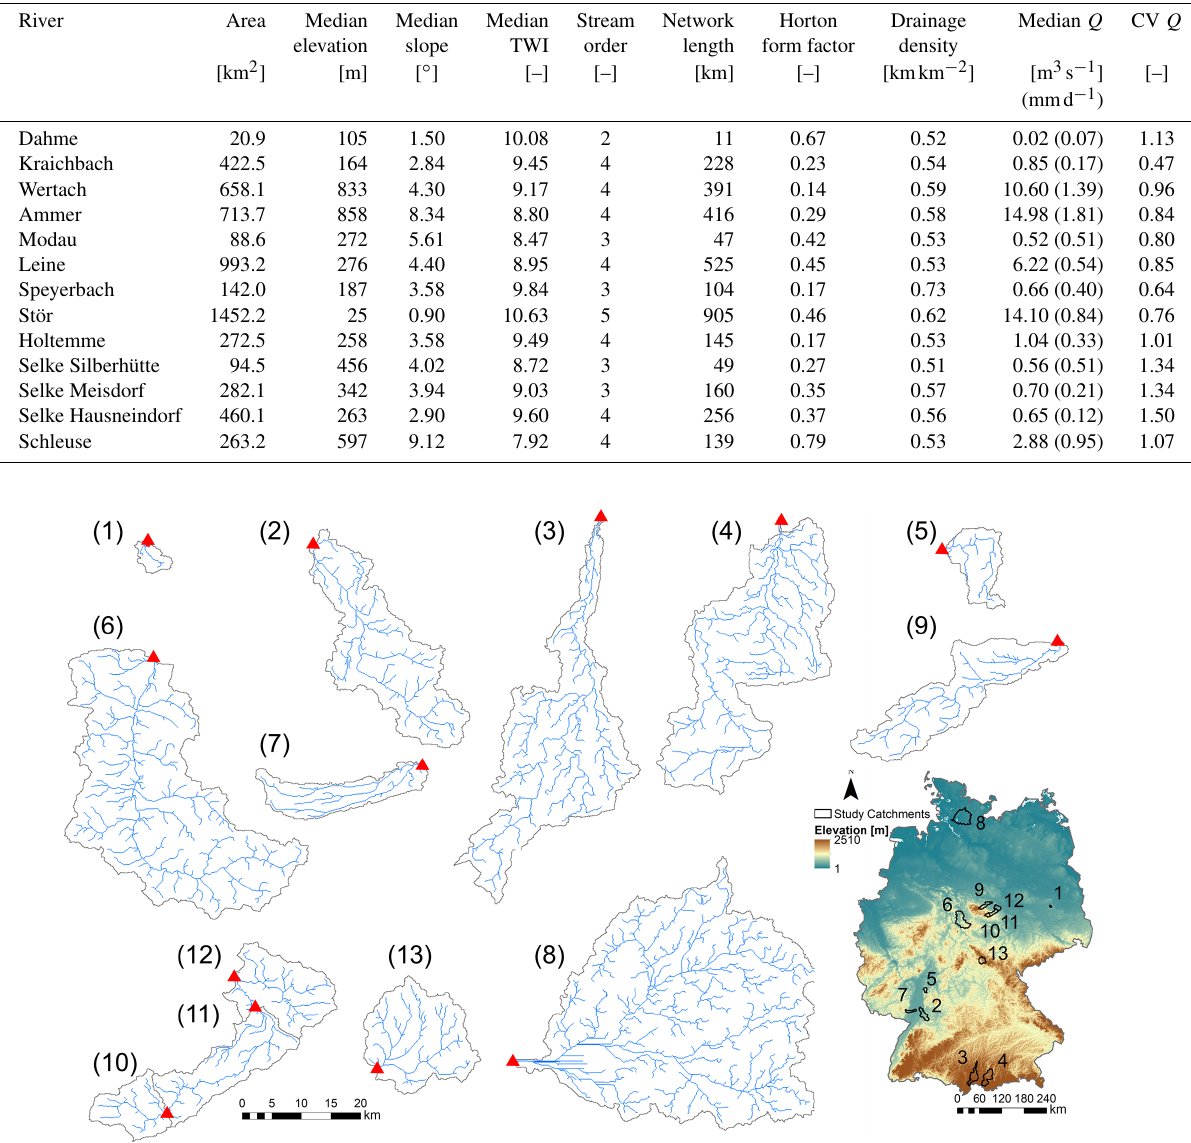
Figure 1. Germany DEM with the location and outline (shape) of selected catchments, along with their drainage networks (in blue) and outlet location (red triangle). See Table 2 for catchment IDs and